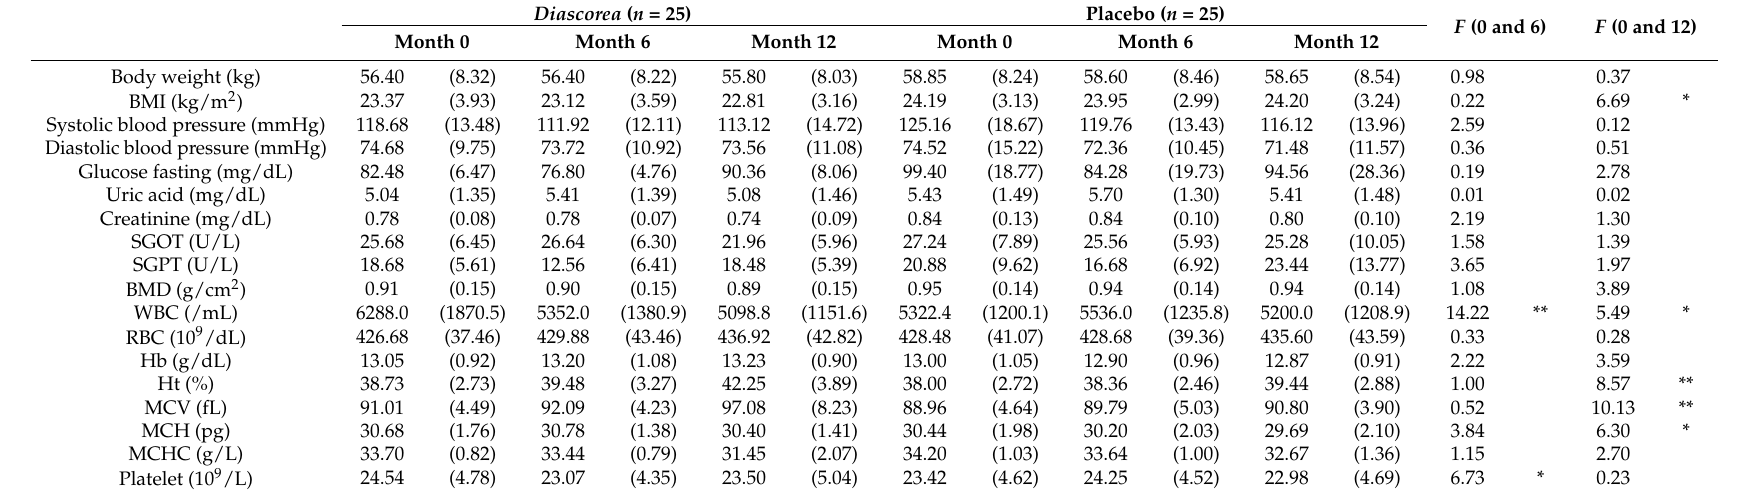
Table 1. The effects of Diascorea on hematological profiles after six and 12 months. Data are given as the mean (standard